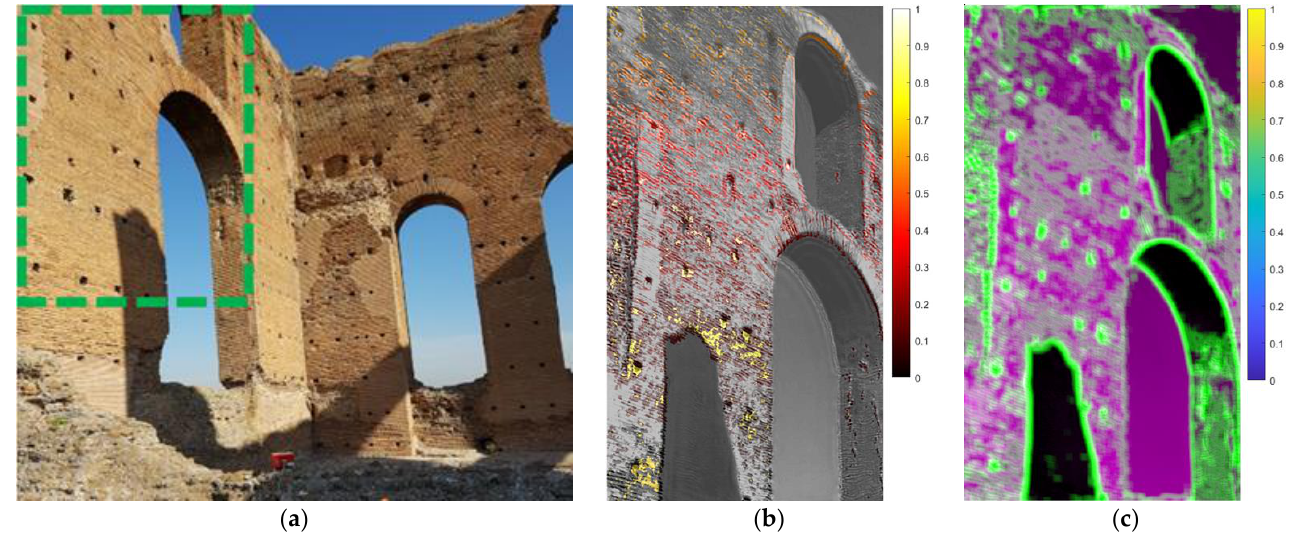
Figure 19. Studied wall of the Calidarium building at the Villa of the Quintili: ( a ) The green dotted rectangle represents the analyzed ROI. The red instrument at the base of the wall is a velocimeter for ambient vibration acquisition. ( b ) Relative normalized displacement pattern after MM within the frequency range 0.6 – 4 .0 Hz and α equal to 35 . ( c ) Image entropy analysis.